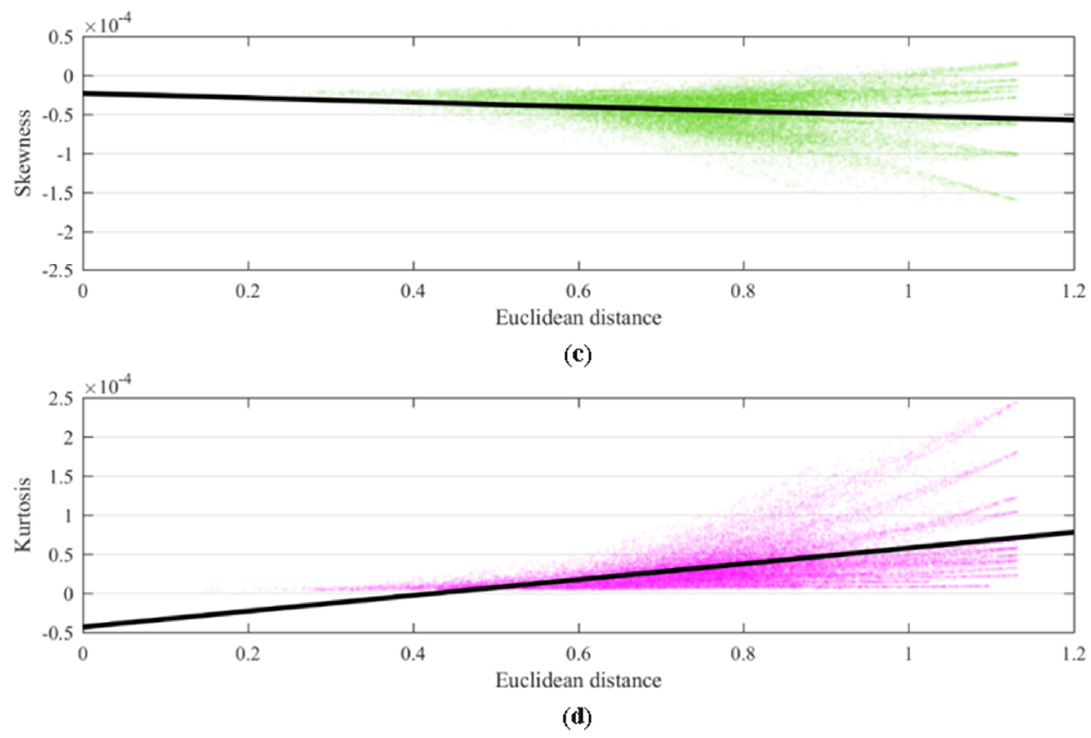
Figure 6. Moments of return according to the Euclidean distance. ( a ) rate of return; ( b ) risk; ( c ) skewness; ( d ) kurtosis.